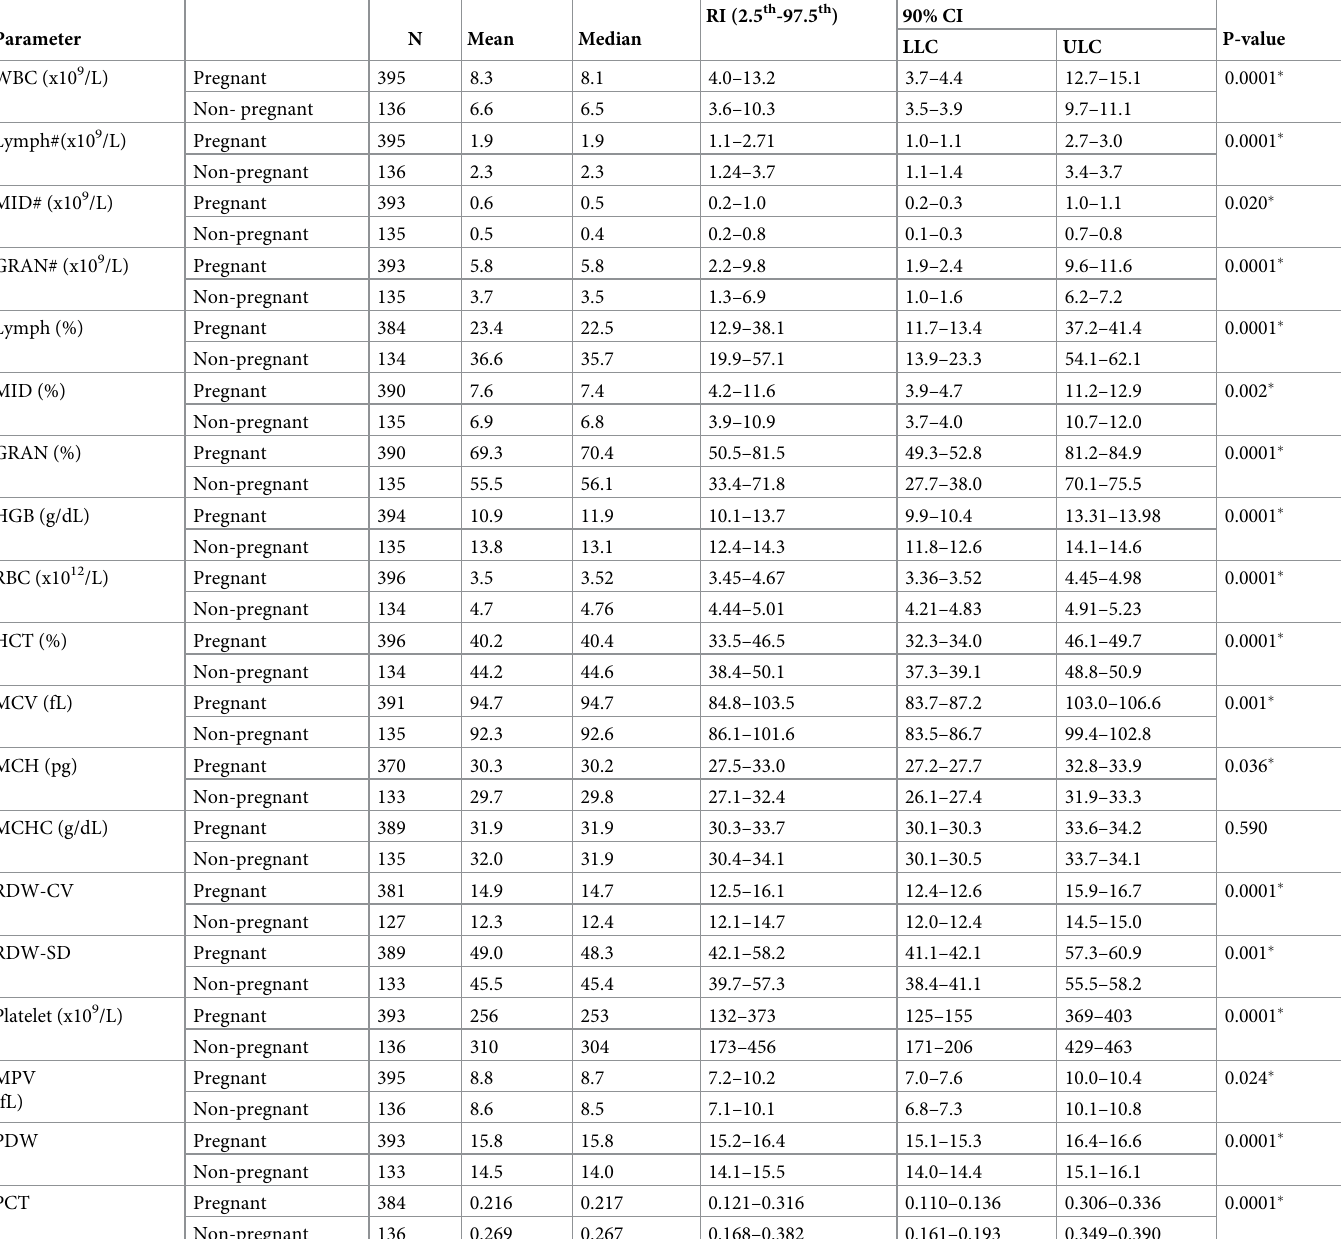
Table 2. Mean, median, 95% (2.5th- 97.5th) RIs with 90% CI for lower and upper reference limits of hematological parameters of pregnant and non-pregnant women of South Wollo zone, Amhara Region, Northeast Ethiopia from June to August,